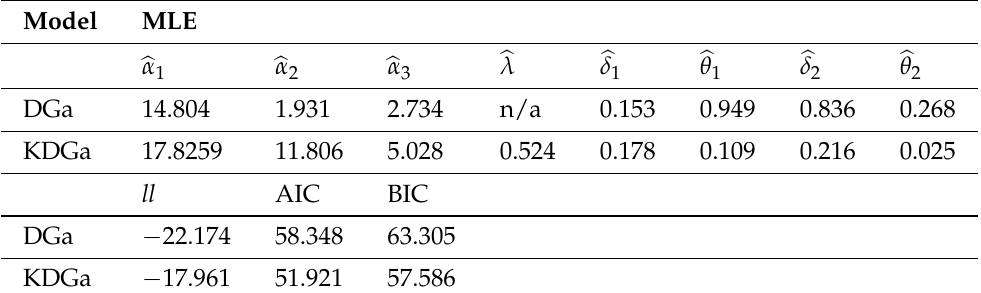
Figure 6. Contour plots of the Dirichlet-gamma and Kummer–Dirichlet gamma distributions on diagnostic probabilities data. Table 2. Parameter estimates and the performance analysis for the diagnostic probabilities data set.